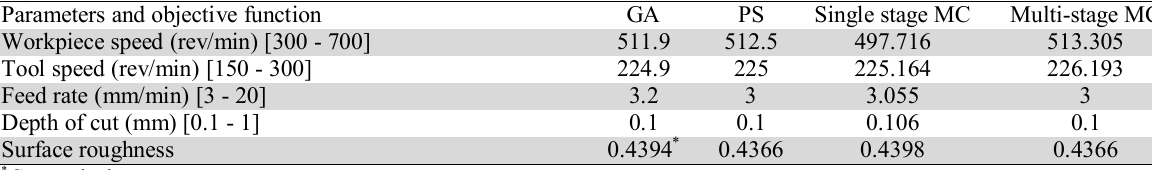
Optimization solutions of case study